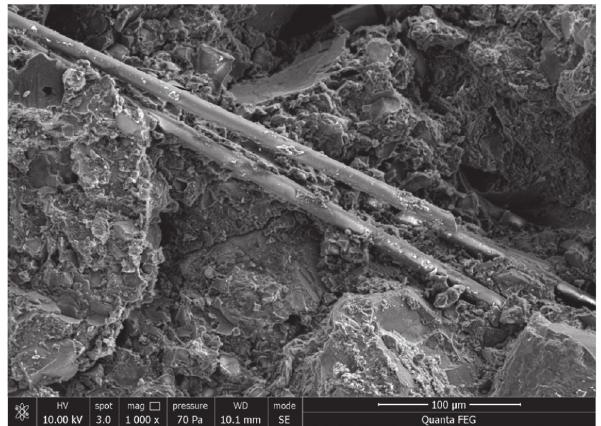
Figure 1: Microscale set up of Zn-AI-Mg-RE coating.